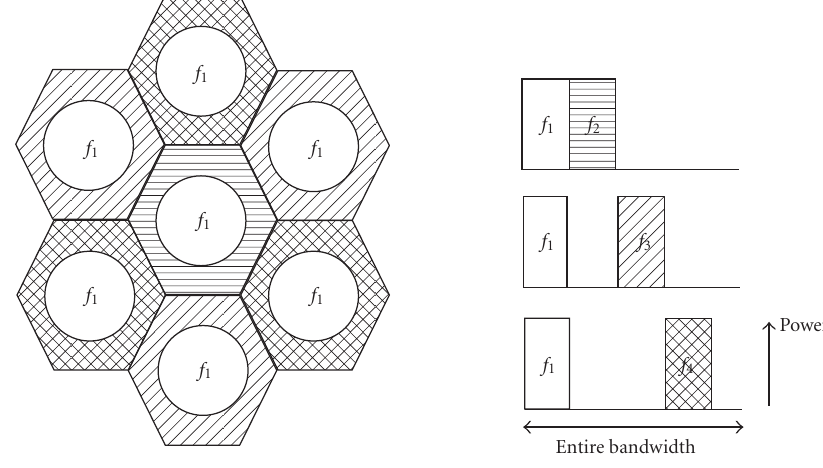
Figure 3: Illustration of FFR scheme.